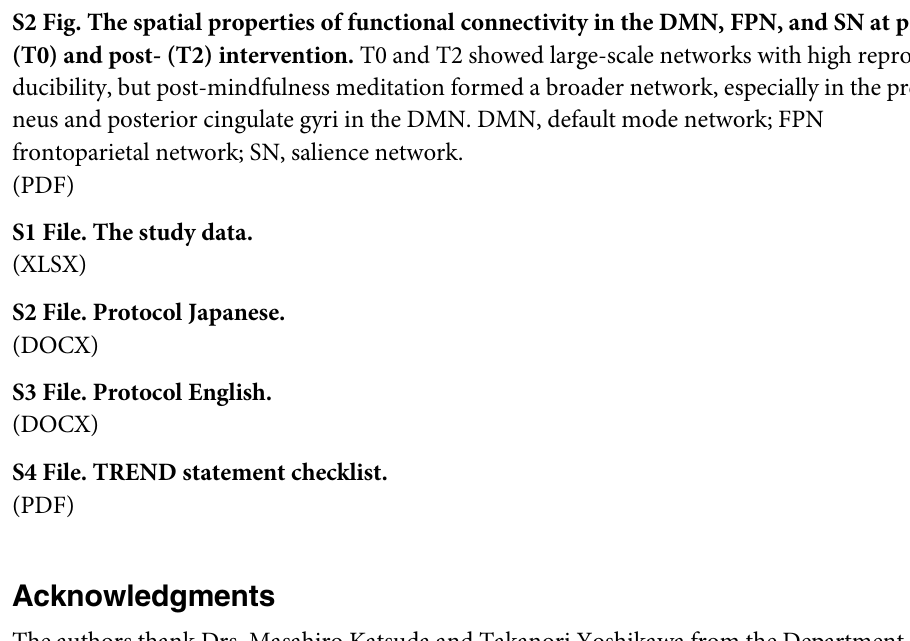
S2 Fig. The spatial properties of functional connectivity in the DMN, FPN, and SN at pre- (T0) and post- (T2) intervention. T0 and T2 showed large-scale networks with high repro- ducibility, but post-mindfulness meditation formed a broader network, especially in the precu- neus and posterior cingulate gyri in the DMN. DMN, default mode network; FPN frontoparietal network; SN, salience